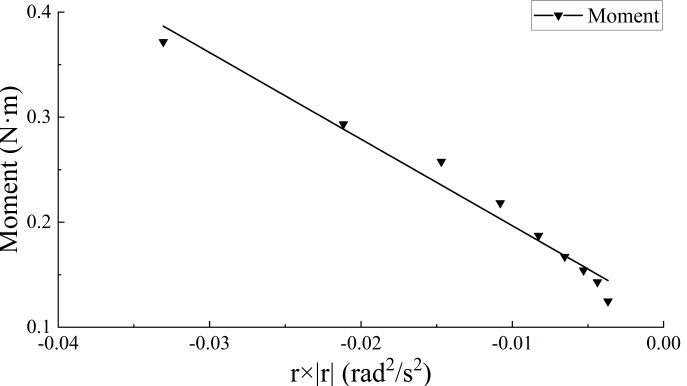
Figure 9. Flow field streamlines around the underwater vehicle in rotating arm test simulation.